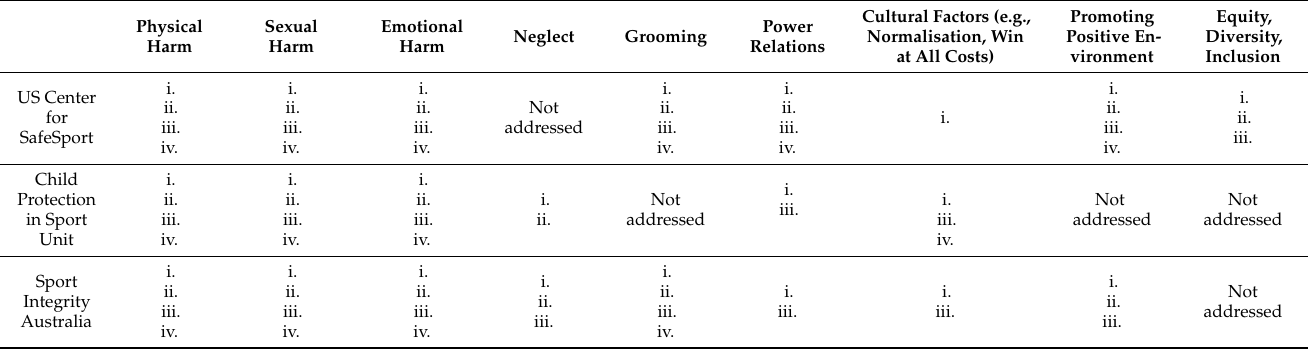
Table A1. 1 Concepts Covered in Basic Safe Sport Course by Organisation.